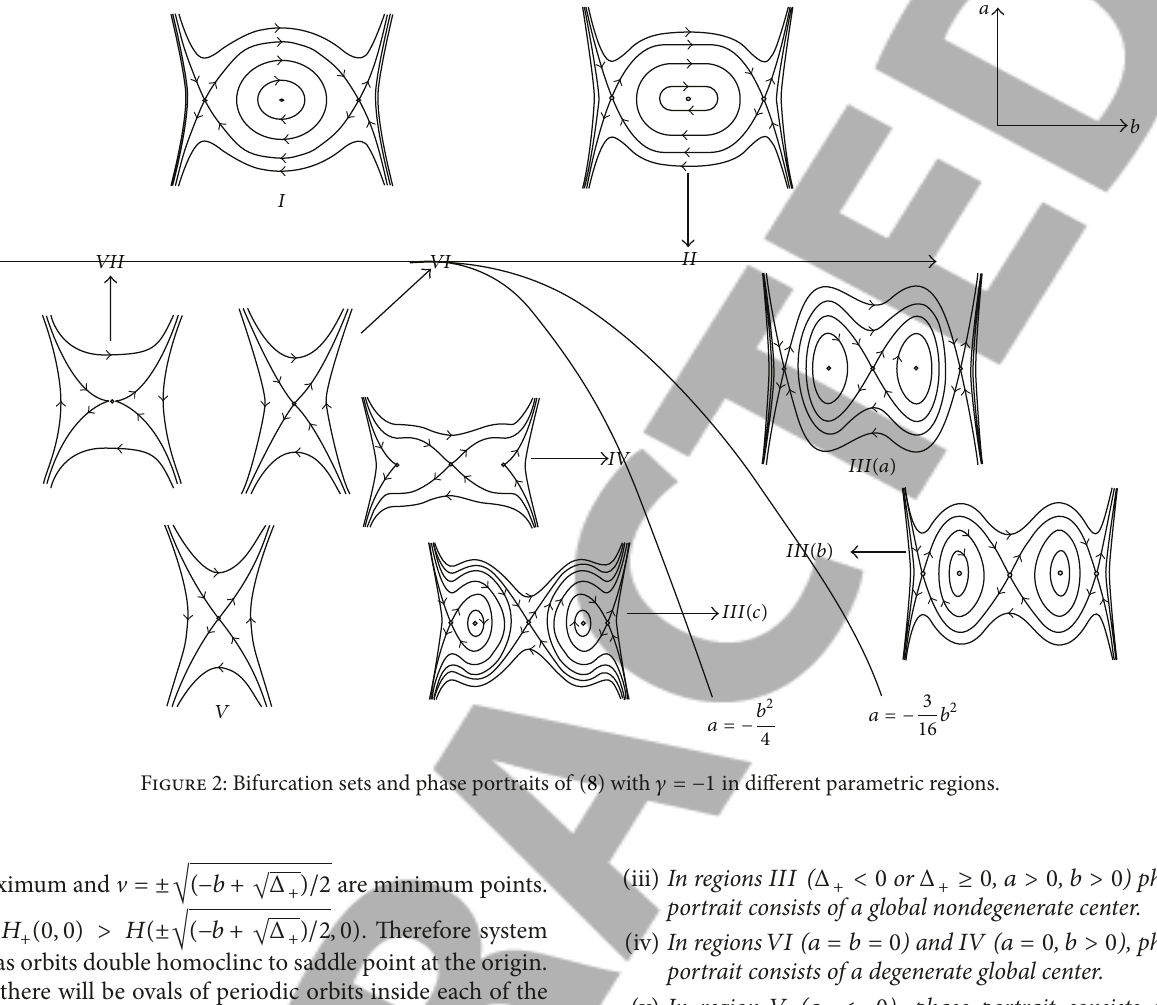
Figure 2: Bifurcation sets and phase portraits of (8) with 𝛾 = −1 in different parametric regions.